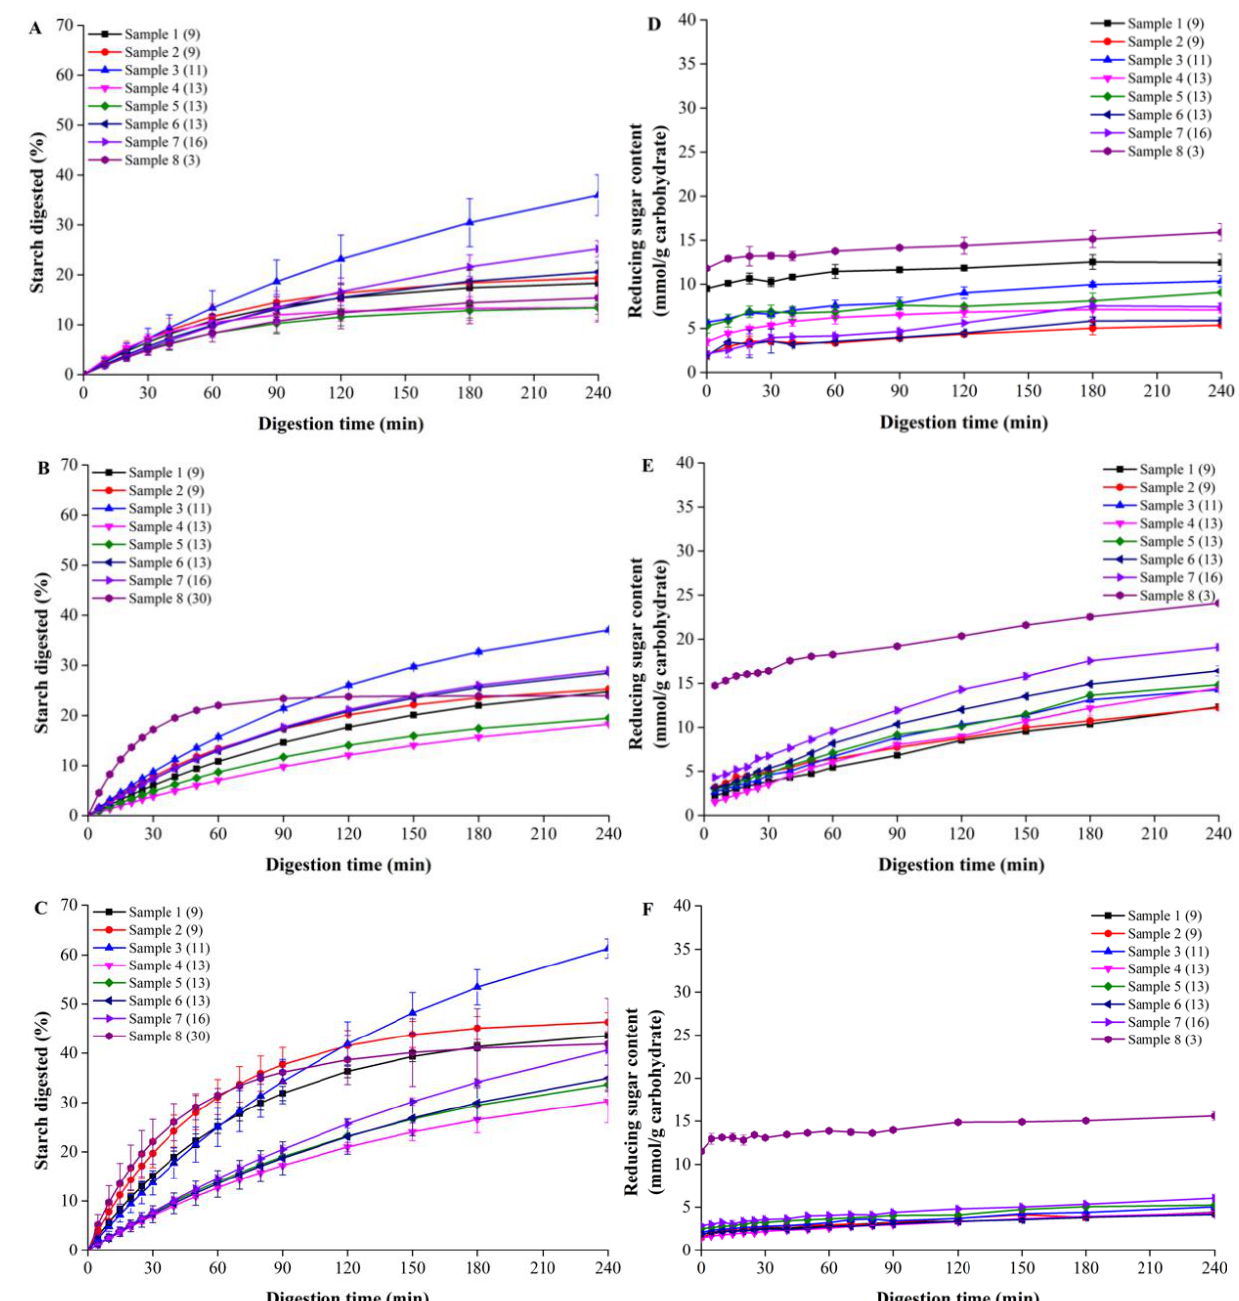
Figure 1. In vitro digestograms of all biscuits using different protocols, including INFOGEST ( A , D ) and single-enzyme protocol using either porcine pancreatin ( B , E ) or pure α -amylase ( C , F ). A, B and C are the digestion data of the percentage of starch digested. D, E and F are the released reducing- sugar content normalized to total available carbohydrates. The value in the brackets are the clinical GI values. Data is based on duplicate measurements.